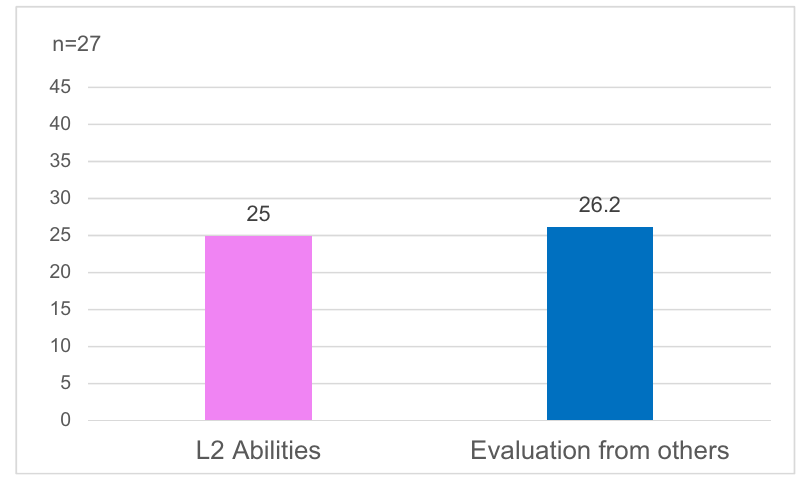
Figure 8: Willingness to speak L2 English under two types of anxiety ( Likert points ) .